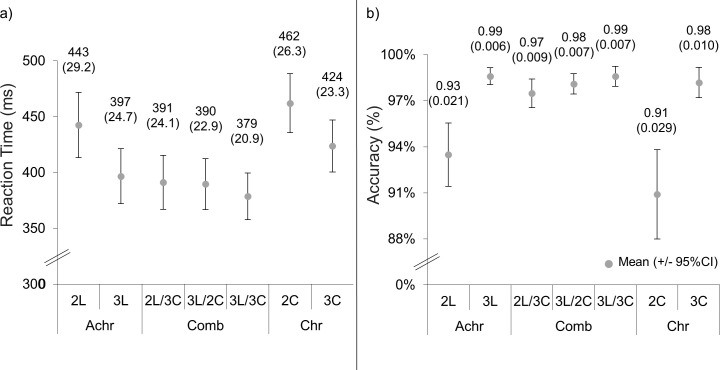
The RTs (a) and accuracies (b) of the EEG task of Experiment 2. The means and 2 standard errors (in brackets) are above each data point. The units are milliseconds and percent for the RTs and accuracies, respectively.